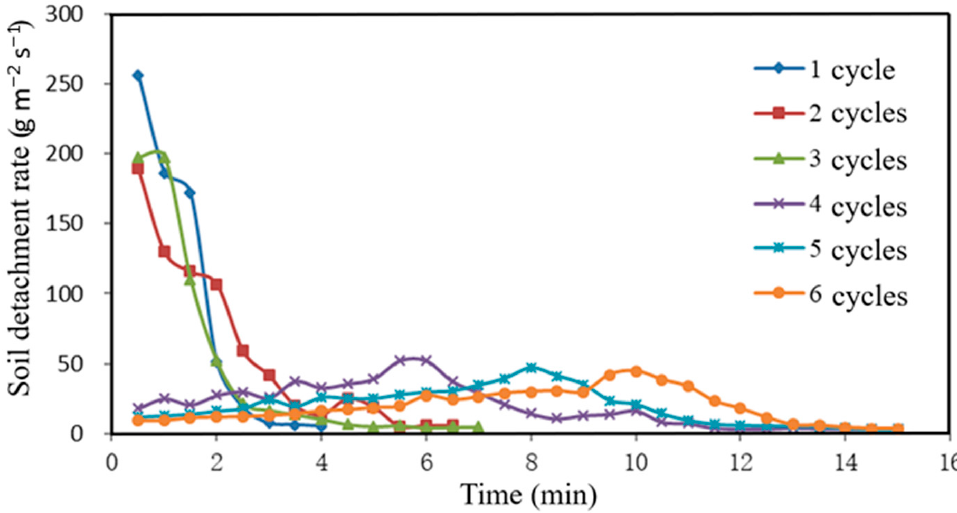
Figure 4. Influence of soil wetting and drying on the soil detachment rate with time. Each data point represents the mean of three replicates.